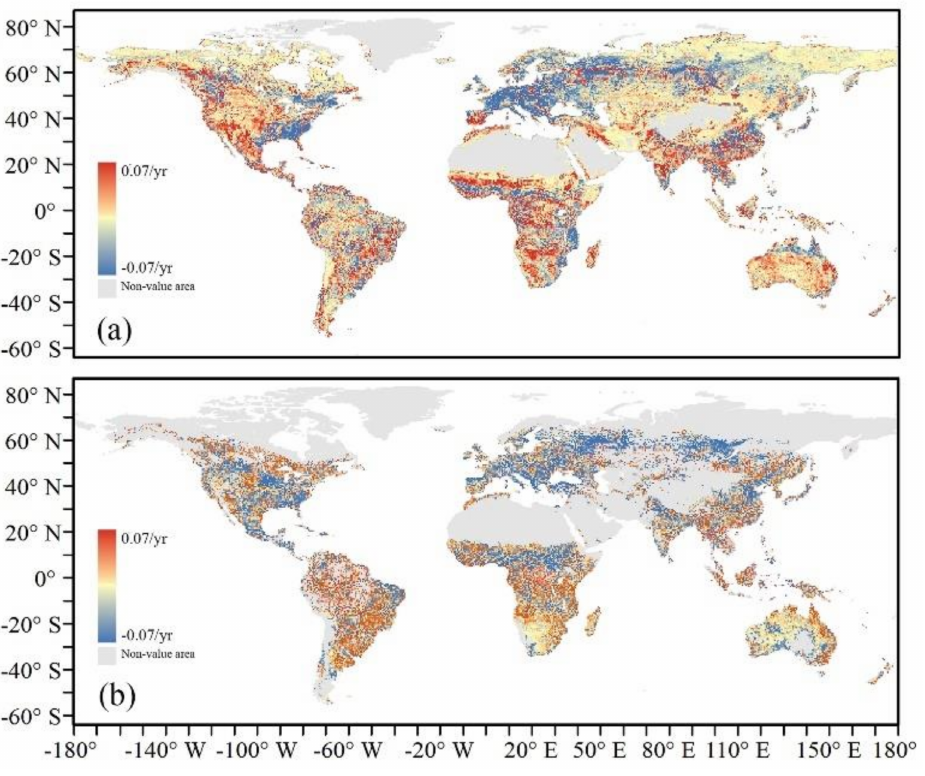
Figure 7. Change rate of terrestrial ecosystem resilience. ( a ) Terrestrial resilience from GLASS LAI, ( b ) terrestrial resilience from GIMMS AVHRR LAI 3g. Non-significant pixels have been